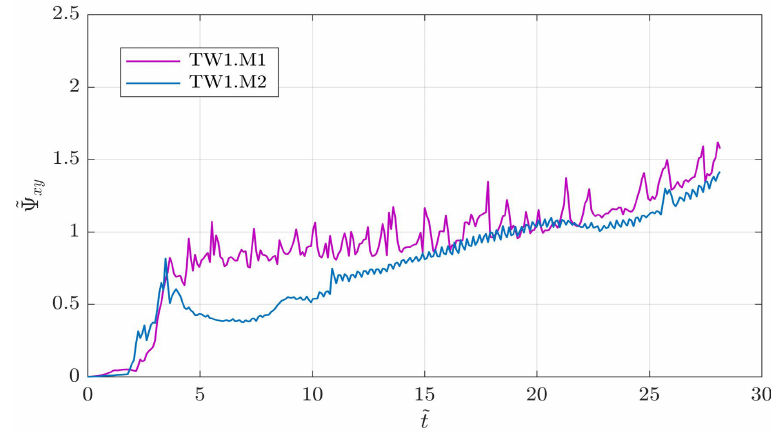
Figure 7. Time series of the dimensionless domain-integral OW parameter ˜ Ψ xy for tests TW1.M1 and